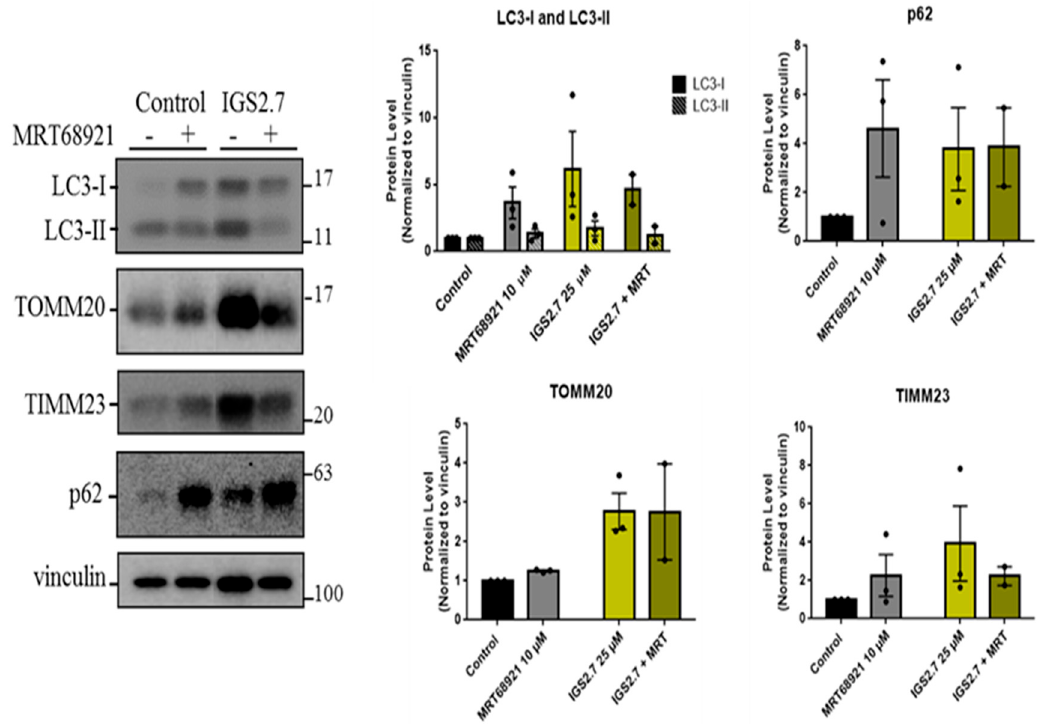
Figure 5. IGS2.7 acted such as the ULK1 inhibitor, MRT68921. Western blot and quantification of LC3-I, LC3-II, p62, TOMM20, and TIMM23. ARPE-19 MitoQC cells were treated with 10 µM MRT68921 and/or 25 µM IGS2.7 for 24 h. Data represent the mean ± SEM of three experiments and were normalized to control .